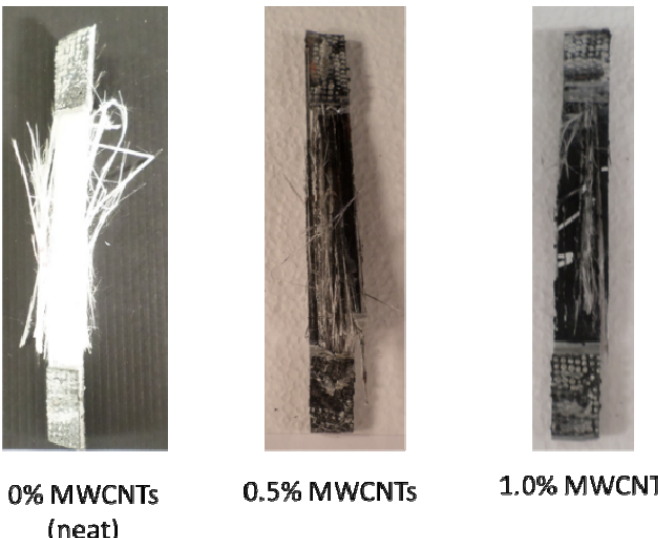
Figure 3. Failure modes of the GFRP composites including 0% MWCNTs (neat), 0.5% MWCNTs, and 1.0%